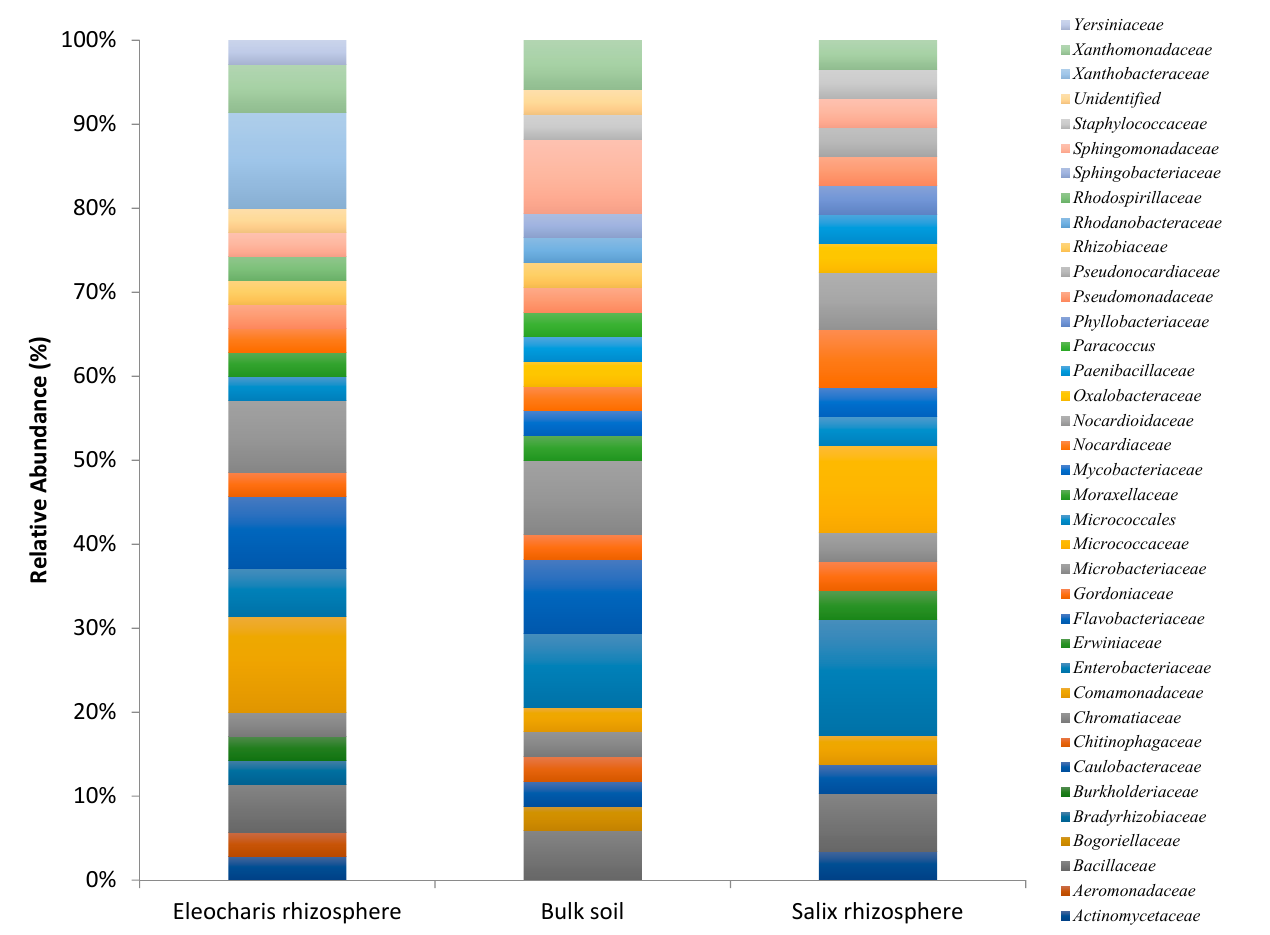
Figure 2. Taxonomic breakdown and relative abundance of bacterial isolates at the family level.